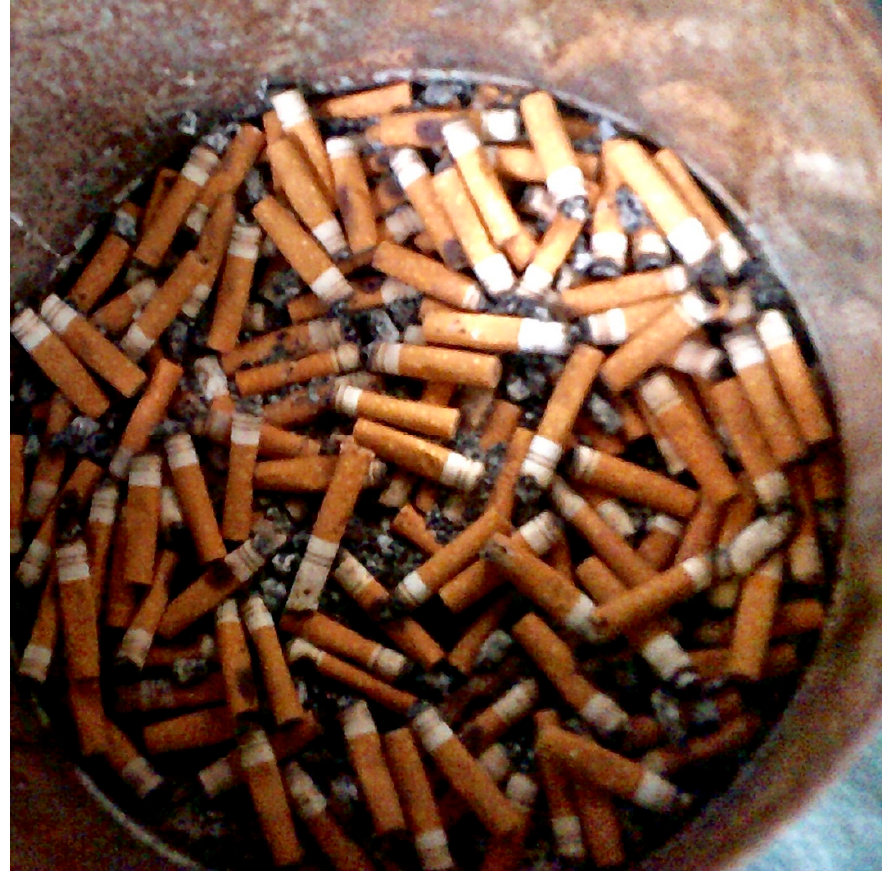
Figure 3. Figure 3. Ashtray .